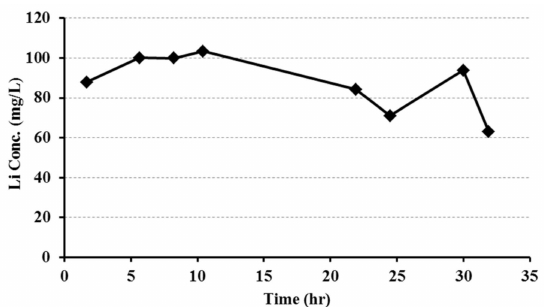
Figure 3. Variation of injected concentration as a function of time at the injection well. The eight measurements of the concentration in the tanks had an average of 88 mg / L with a standard deviation of 14 mg / L.